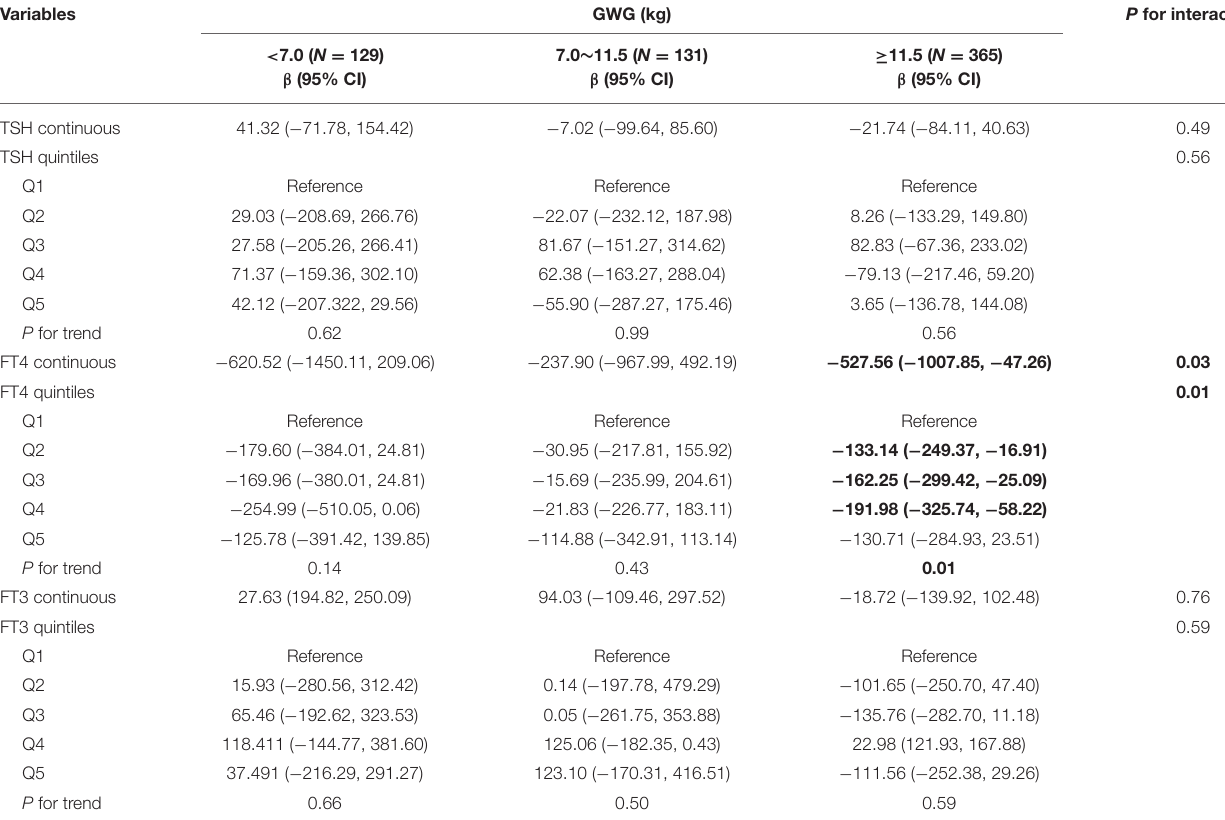
TABLE 6 | Adjusted regression coefficients a for birth weight associated with maternal thyroid parameters during early pregnancy stratified by GWG among overweight women ( N = 625).